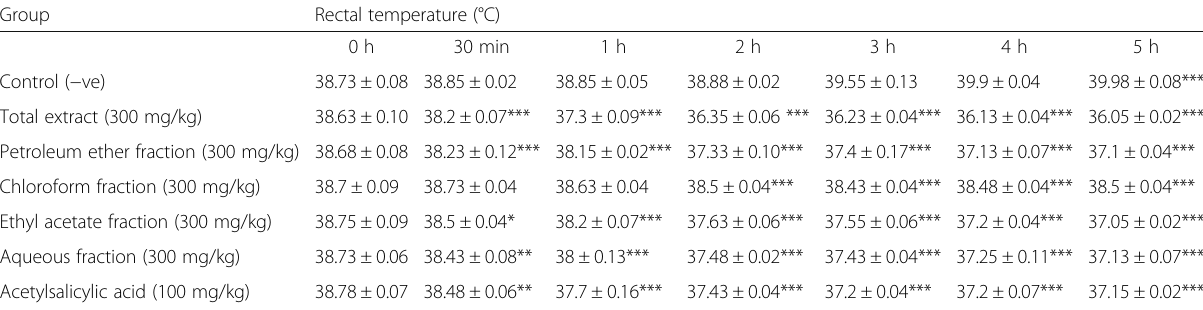
Table 5 Results of the antipyretic activity of the total ethanolic extract and different fractions of A. hirtum leaves on yeast – induced pyrexia method